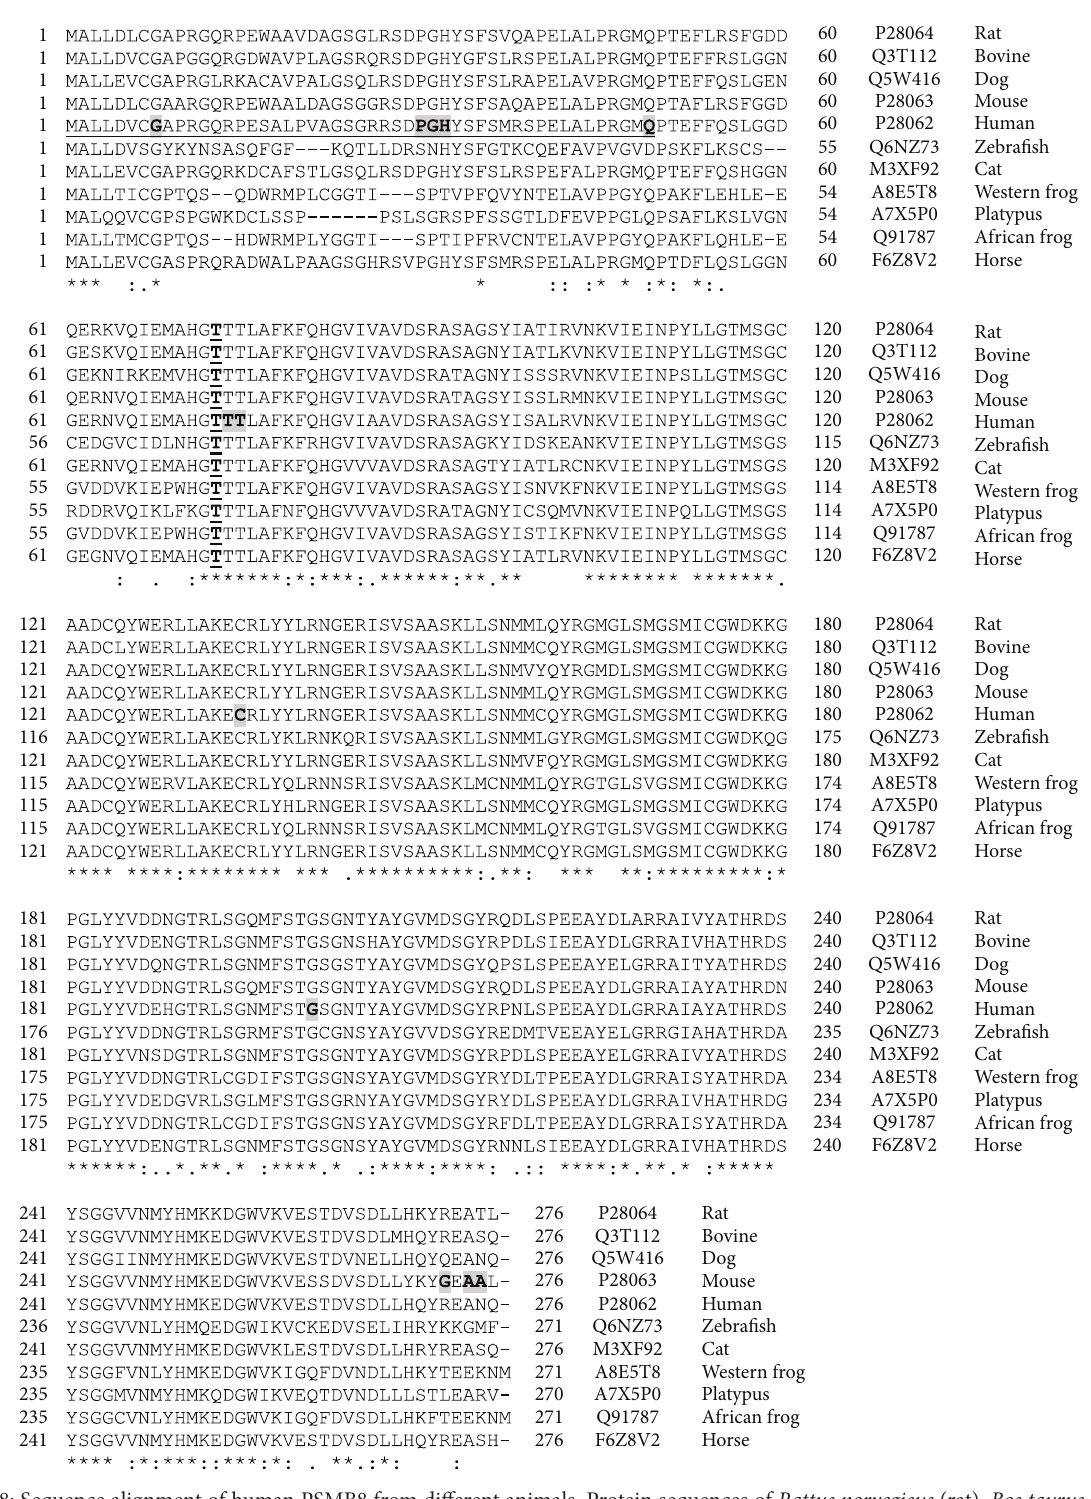
Figure 8: Sequence alignment of human PSMB8 from different animals. Protein sequences of Rattus norvegicus (rat), Bos taurus (bovine), Canis familiaris (dog), Mus musculus (mouse), Homo sapiens (human), Danio rerio (Zebrafish), Felis catus (Cat), Xenopus tropicalis (western clawed frog), Ornithorhynchus anatinus (Duckbill platypus), Xenopus laevis (African clawed frog), and Equus caballus (Horse) PSMB8 were aligned using Clustal W. ⋆ , identical residue in all six subunits; :, conserved amino acids with strongly similar properties; ., conservation between residues of weakly similar properties. Naturally occurring variants are highlighted with grey boxes. Alternatively spliced regions are underlined. Amino acid residue numbers are shown on the left and right of each sequence and the UniProt accession number is also